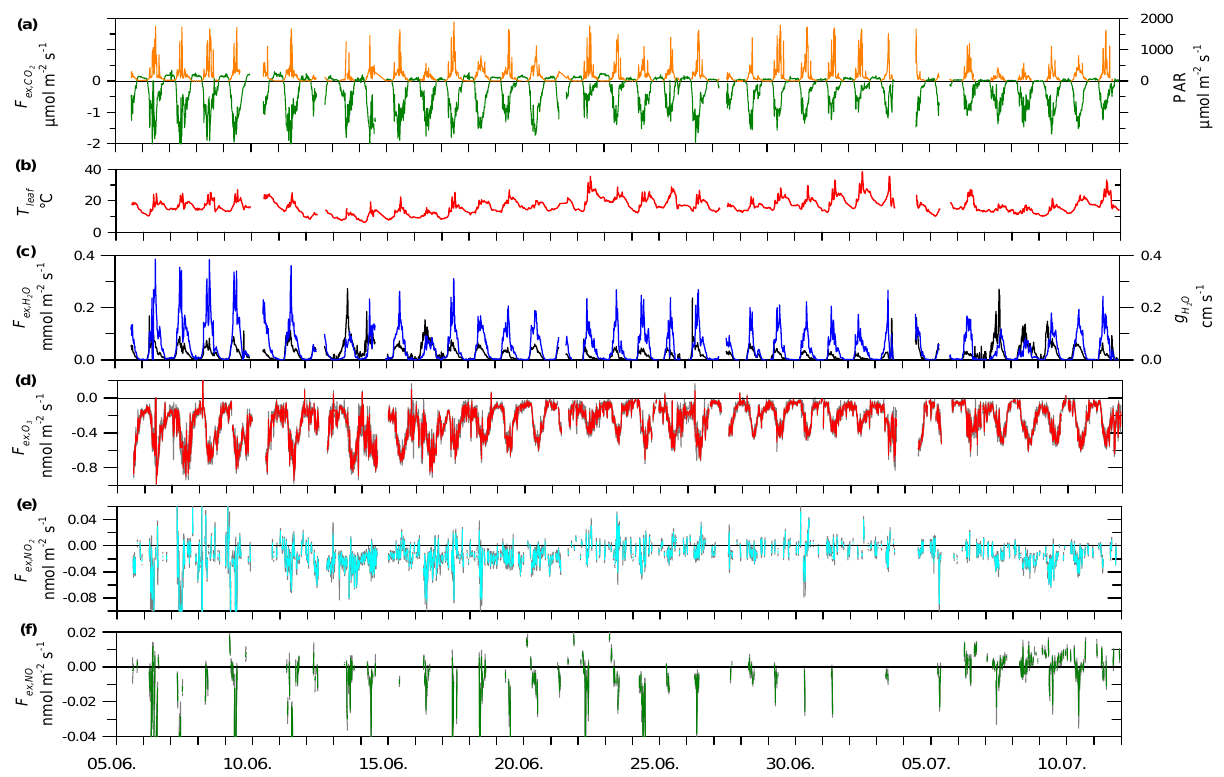
Figure 2. Overview of exchange rates over the entire measurement period. (a) photosynthesis rate F ex,CO2 (green line), PAR (orange line); (b) leaf temperature T leaf ; (c) transpiration rate F ex,H2O (blue line), leaf conductance ( g H2O ) (black line); (d) O 3 exchange flux F ex,O3 (red line); (e) NO 2 exchange flux F ex,NO2 (light blue line); (f) NO exchange flux F ex,NO (green line). F ex,O3 , F ex,NO2 , F ex,NO based on data pairs which were significant for Δ m i = ( m a,i – m s,i ) and their errors are shown as gray areas.